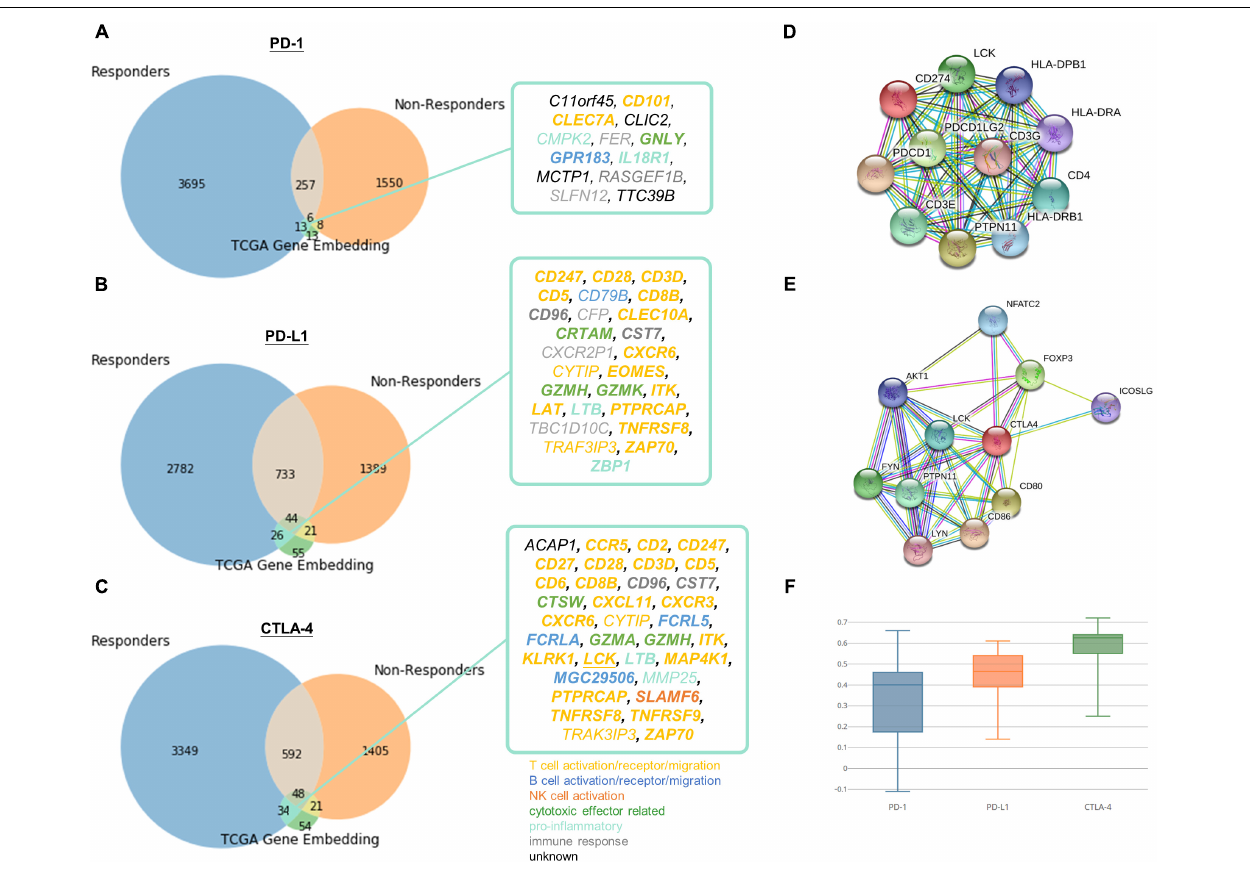
FIGURE 5 | Identification of potential related genes for immune checkpoint blockade therapy responsiveness. Venn diagram of neighboring genes in simulated immunotherapy responders and non-responders with (A) PD-1, (B) PD-L1, (C) CTLA-4 and its corresponding neighbors in TCGA gene entity space. Functionally interacting partner (in STRING or BioGRID) are underlined. Gene relatedness supported by the literature are in bold. Genes related to T cell, B cell, NK cell, cytotoxic effector, pro-inflammatory, or immune response are highlighted in yellow, dark blue, orange, green, light blue, and gray, respectively. Known and predicted protein-protein interaction of (D) PD-1 and PD-L1, and (E) CTLA-4 were retrieved from STRING. (F) Boxplot of Pearson correlation between gene candidates and respective immune checkpoint